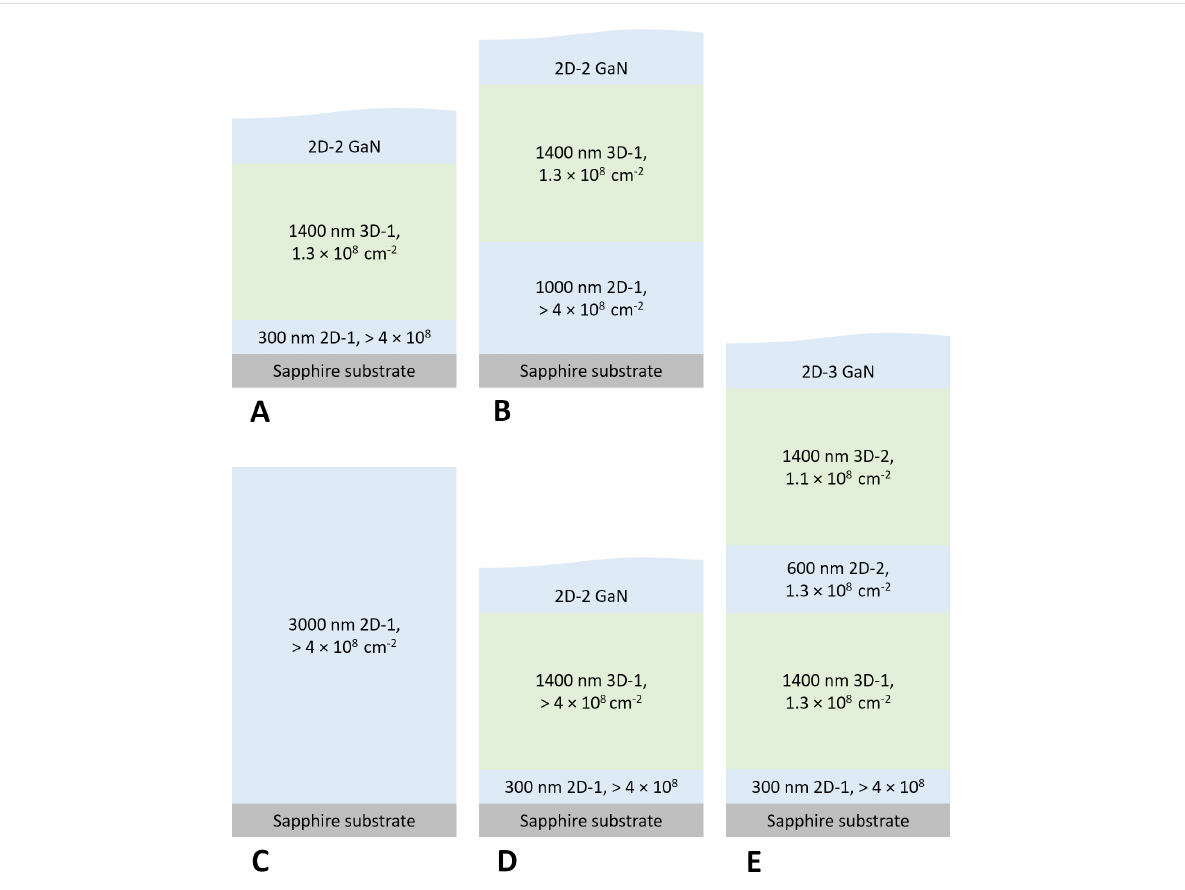
Figure 1: Epitaxial stack designs A – E grown by MOCVD. Different sequences of 2D and 3D GaN were prepared. Thereby, varying dislocation densi- ties were achieved, which are indicated in the figure for each individual GaN layer. The dislocation density values were determined by PL and XRD.